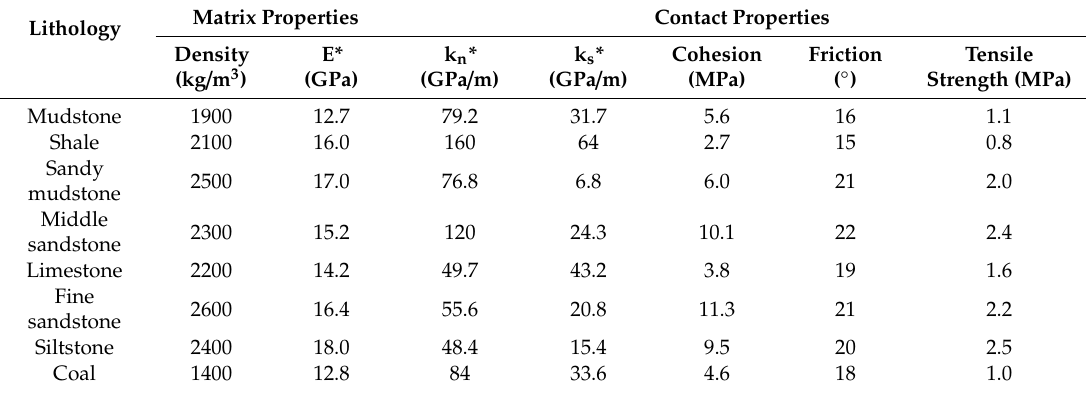
Figure 4. Uniaxial compression test and stress-strain curves for the rock mass. ( a ) Schematic picture of Shimadzu AG-X250 electronic universal testing machine; ( b ) Axial stress-strain curves of uniaxial compression test on fine sandstone. Table 1. Mechanical properties used in the UDEC